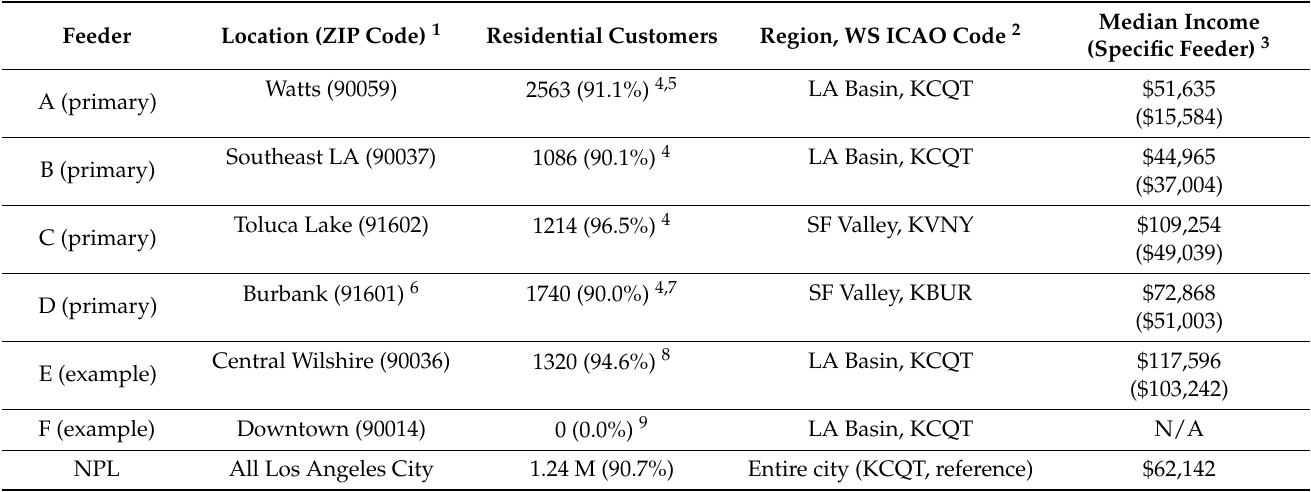
Table 1. Summary of sampled feeders including feeder service area and service demographic